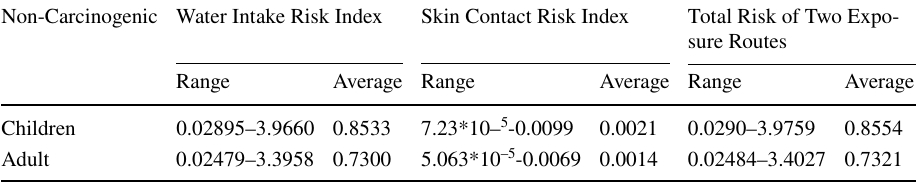
Table 6 Non-carcinogenic risk of nitrate for children and adults in drinking water and dermal contact